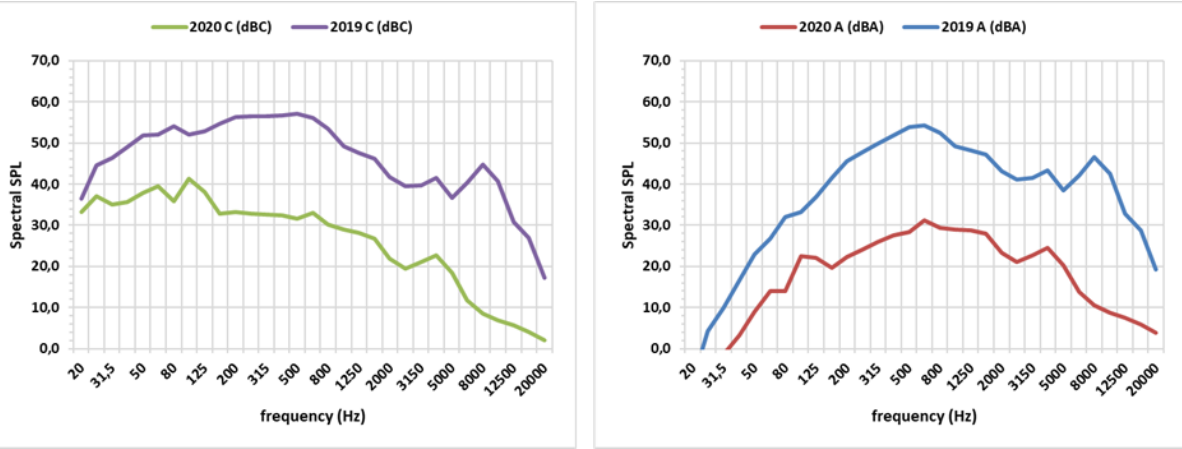
Figure 8: Overall C and A-weighted sound spectrum in 2019 vs 2020 at site no. 3